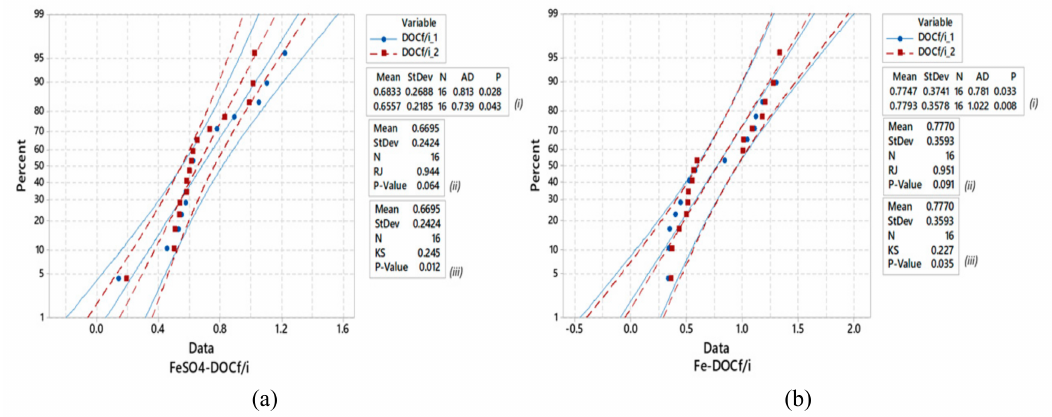
Figure 2. Normal probability plot of the DOCf / i factor with 95% Cis in the ( a ) FeSO 4 treatment and ( b ) Fe(0) treatment. DOCf / i_2: Dissolved organic carbon removal factor Replicate 1; DOCf / i_2: Dissolved organic carbon removal factor Replicate 2; n : Number of samples; (i) AD: Andersons Darling; (ii) RJ: Ryan Joiner; (iii) KS: Kolmogorov